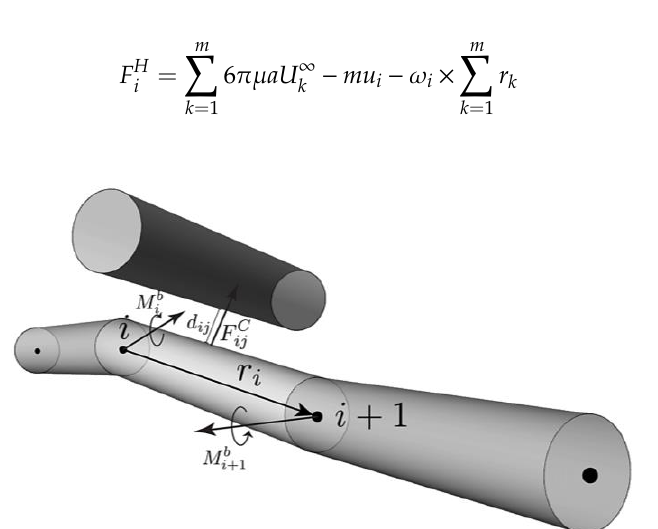
Figure 2. Fiber represented as a chain of segments. Positions are stored at the segment nodes.